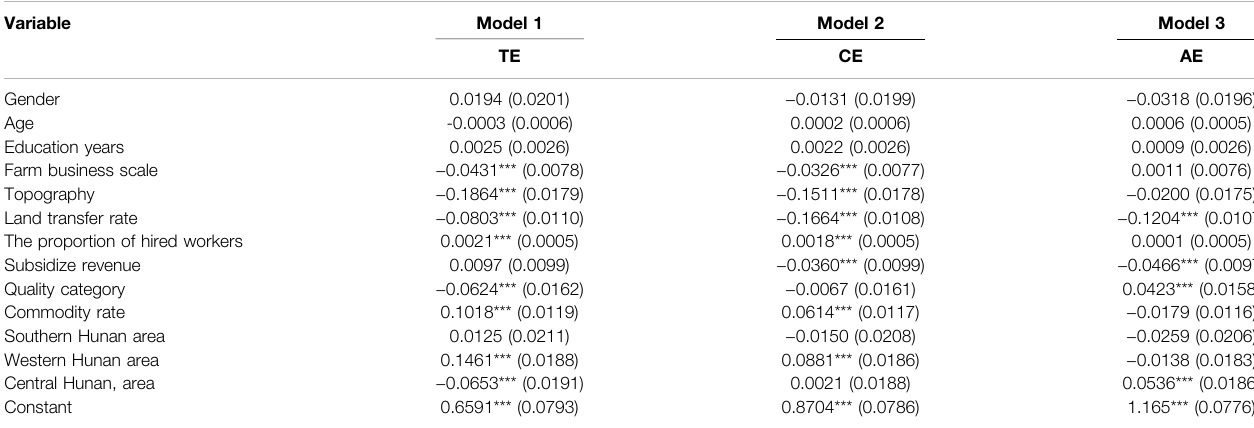
TABLE 3 | Analysis of factors affecting cost ef fi ciency of rapeseed production in